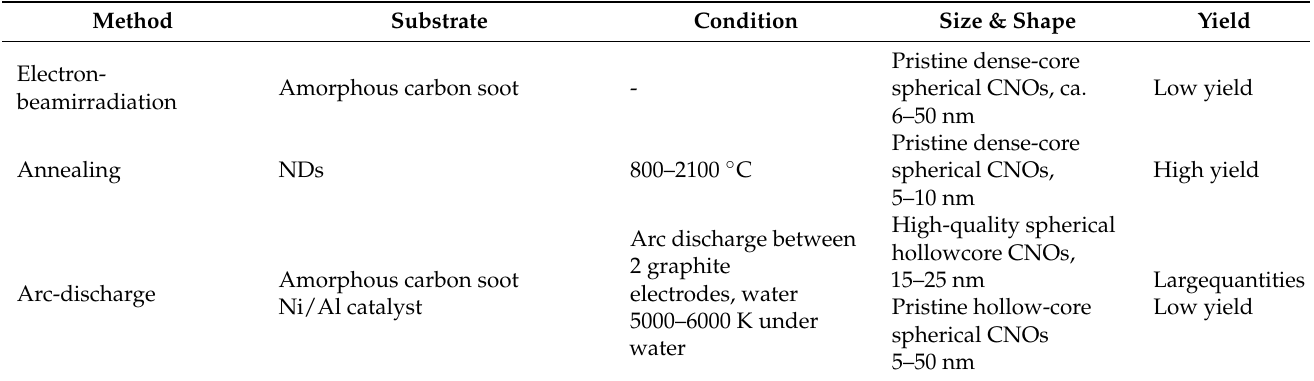
Table 1. Methods of CNOs synthesis